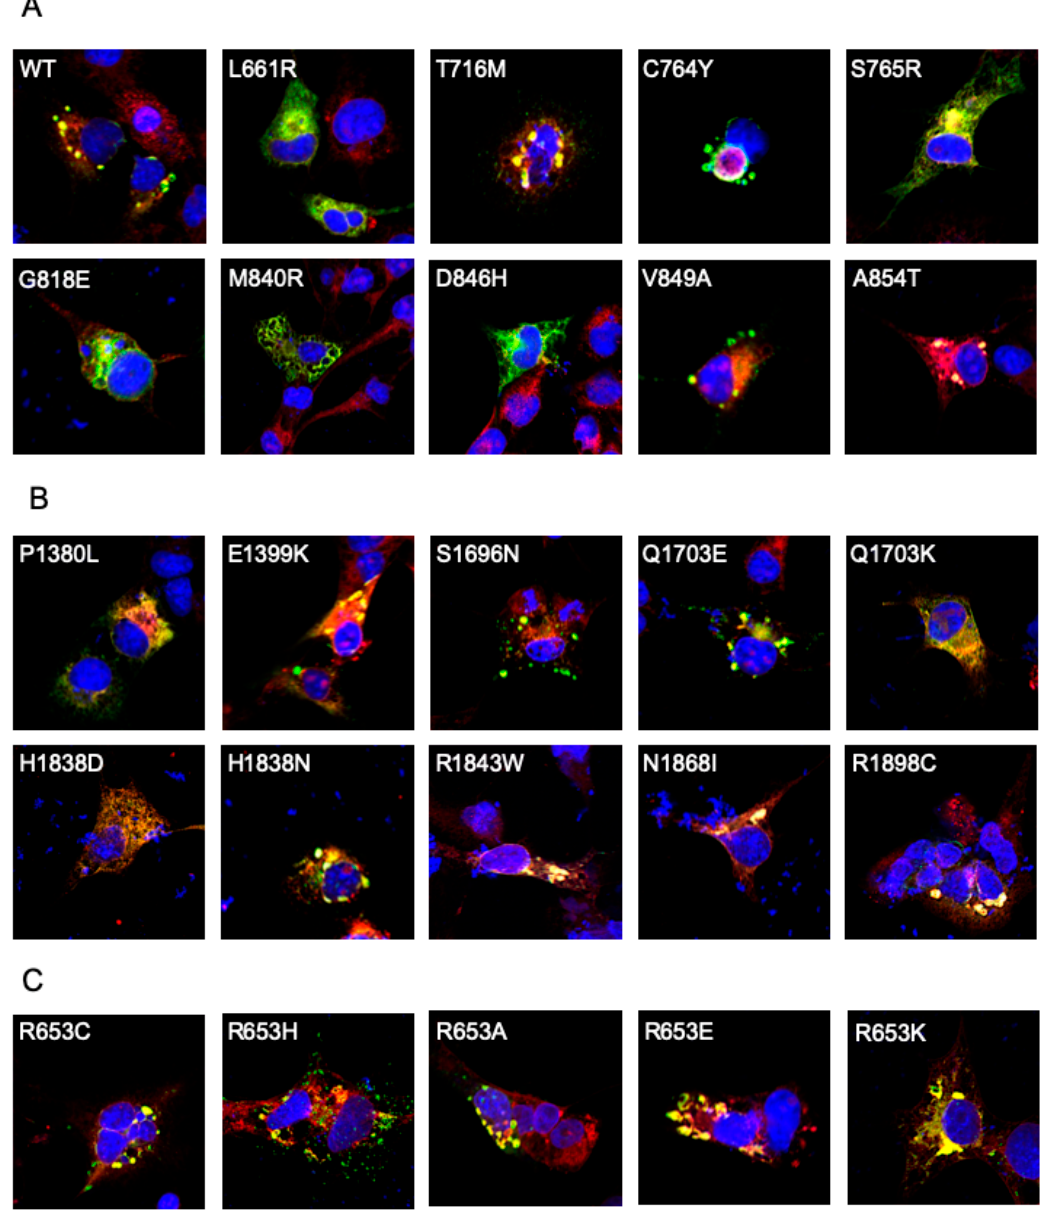
Figure 3. Cellular localization of TMD and R653 variants. Representative immunofluorescence micrographs of ABCA4 variants expressed in COS7 culture cells. The prevalence of vesicles is observed in cells expressing WT ABCA4 and variants with high levels of expression following CHAPS solubilization observed in Figure 2. Prevalence of reticular localization is observed in TMD variants with low solubilization. ( A ) Representative TMD1 variants; ( B ) Representative TMD2 Variants. ( C ) p.R653 Variants. GREEN—Rho1D4 antibody used to label ABCA4 variants containing the 1D4 tag; RED—anti-calnexin used as an ER marker; BLUE—DAPI (nucleus).